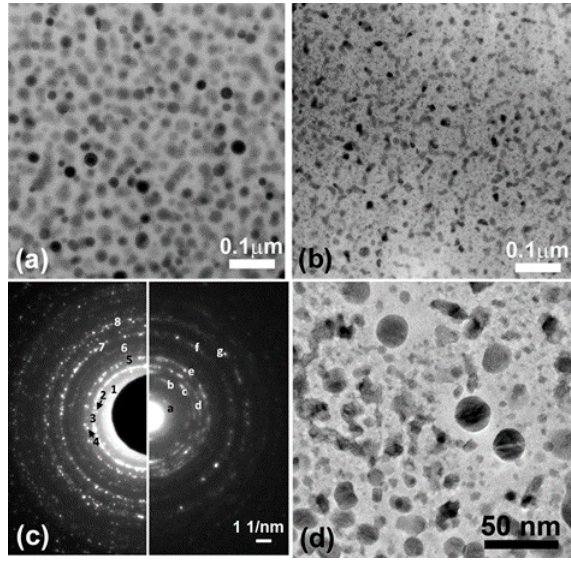
Figure 5. Plan-view TEM of the ( a ) top oxide layer, ( b ) transition layer and ( c ) Comparison of SAED pattern taken from the top oxide layer (left) and transition layer (right). ( d ) Plan-view TEM of the oxide/transition layer interface in the annealed Hf 6 B 10 Si 31 C 2 N 50 film.